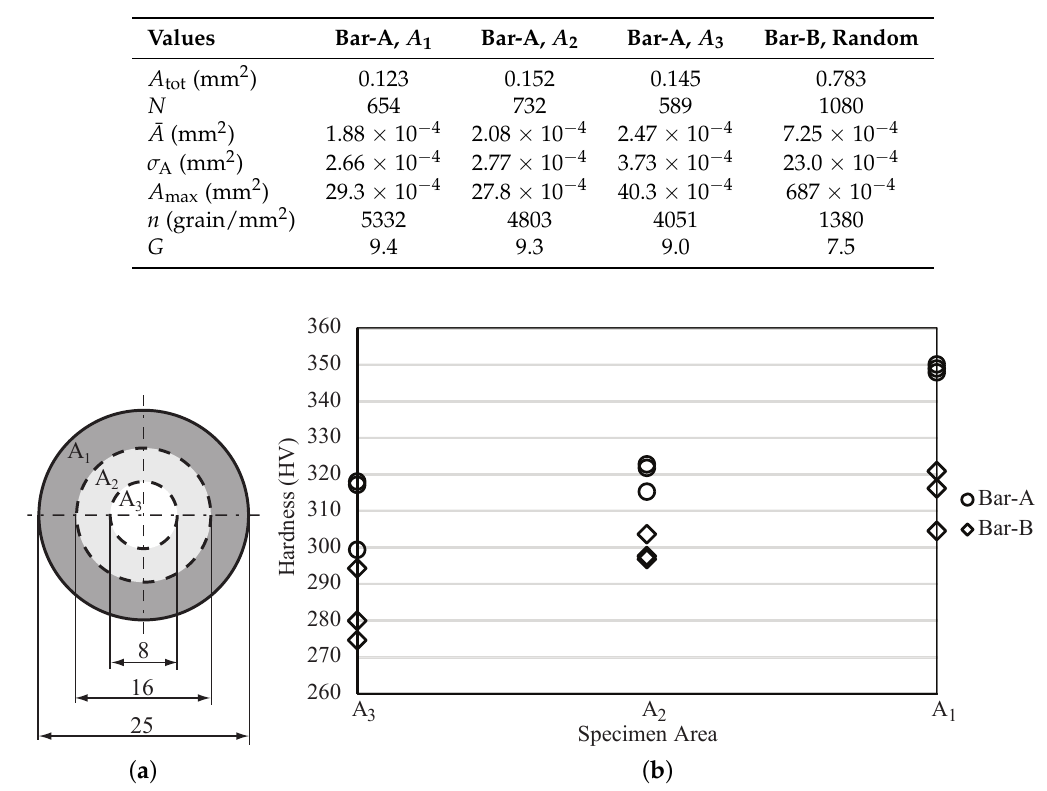
Figure 7. Hardness tests: identification of specimen regions ( a ) and hardness measures ( b